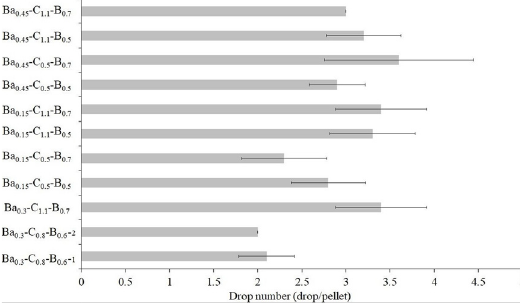
Figure 3. Influence of the composition on tumble index of the fired iron-ore pellets.